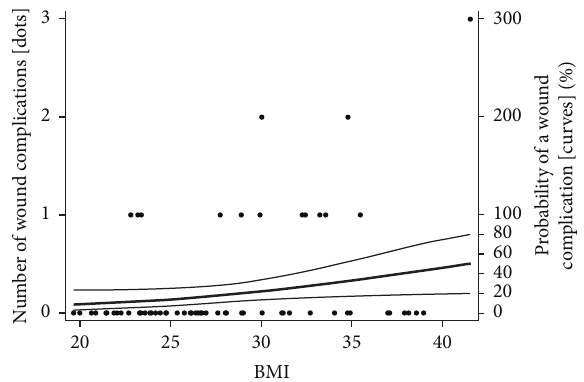
Figure 4: Influence of BMI on wound complications. The graph shows a scatter-plot of BMI and the number of wound complica- tions, with the regression curve and 95% CI superimposed using the right-side axis. Dots represent the actual data of BMI and wound complications from this study. The middle curve represents the probability of a wound complication, and the upper and lower curves show the interval within which the probability curve can be assumed with 95% confidence to lie. The statistical parameters for this model were as follows: regression slope = 0.11, 95% CI =